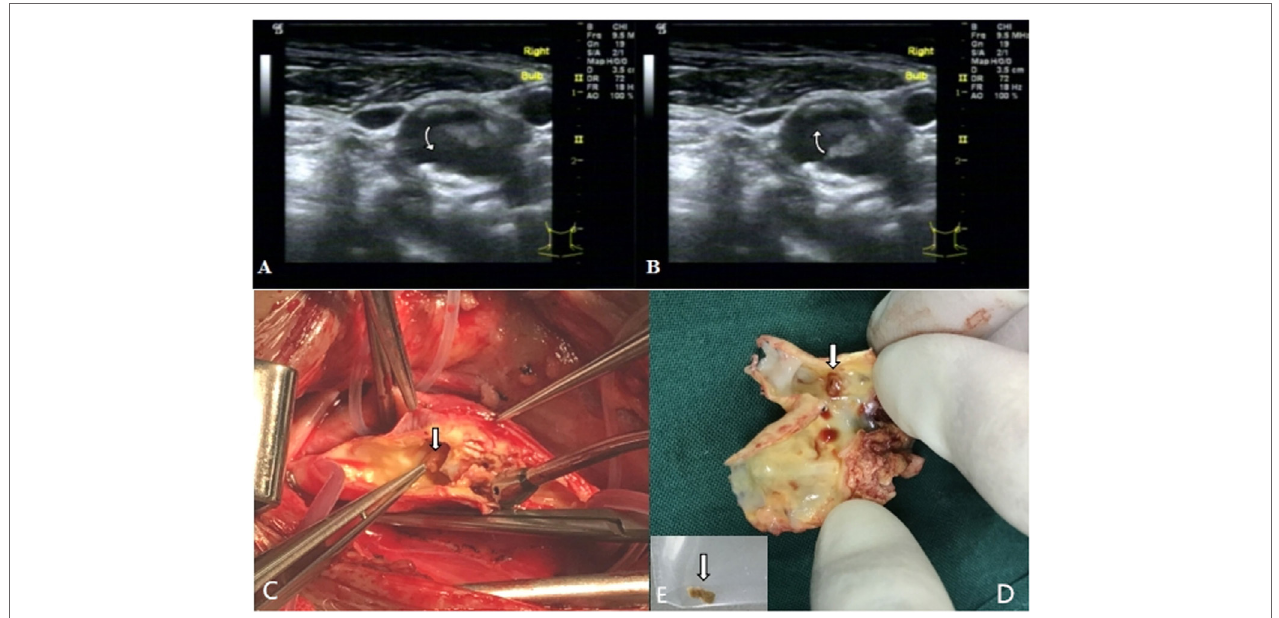
FIGURe 1 | The two-dimensional ultrasonography of right carotid artery shows that the floating carotid plaques in the medial wall of the bifurcation of the distal carotid artery, moving with the cardiac cycle [ (a,B) arrows]. The floating material with pedicel can be found in the bifurcation of carotid artery during operation [arrows (C) ]. The floating material [arrow (e) ] was stripped off from the base of the desquamated plaque [arrow (D) ].